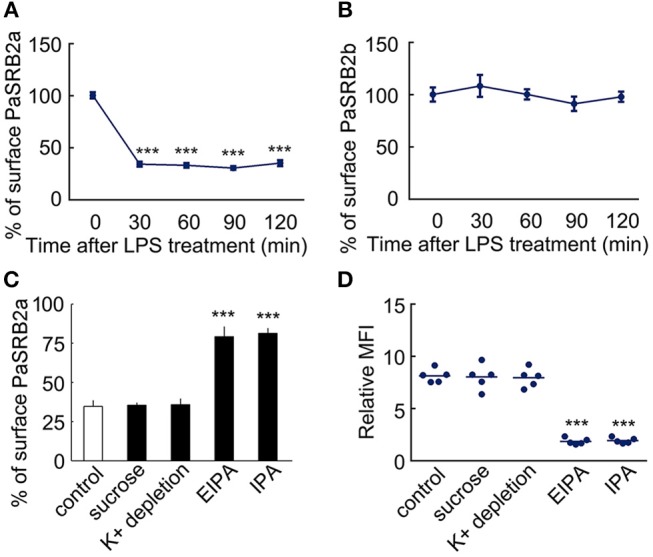
LPS internalization accompanied PaSRB2a endocytosis in ayu macrophages. (A) Surface levels of PaSRB2a were measured by flow cytometry at different time points after treatment with 10 μg/ml LPS. (B) Surface levels of PaSRB2b were measured by flow cytometry at different time points. (C) Surface levels of PaSRB2a after treatment with chemical clathrin-mediated endocytosis inhibitors (sucrose and K+ depletion) or clathrin-independent endocytosis inhibitors (EIPA, 5-(N-ethyl-N-isopropyl) amiloride and IPA, IPA-3). (D) LPS internalization after treatment with membrane endocytosis inhibitors. Each bar represents the mean ± SE. n = 5. Data are representative of three independent experiments. ***P < 0.001.